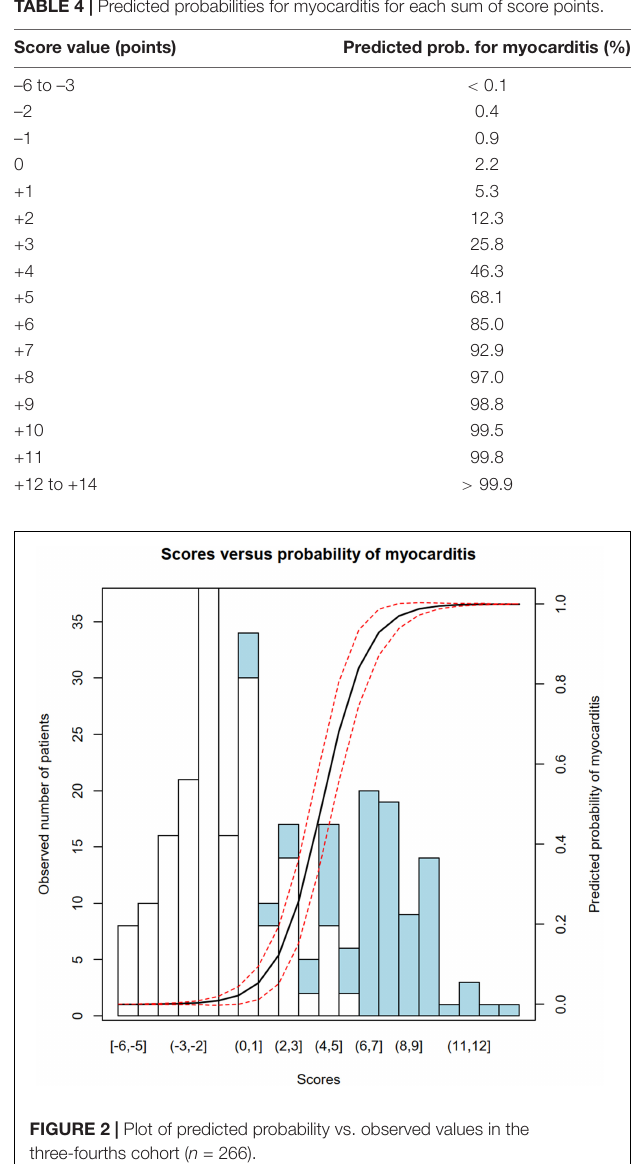
myocarditis (#2: ≥ 7, Sens.: 73.1%, Spec.: > 99.9%, PPV: >